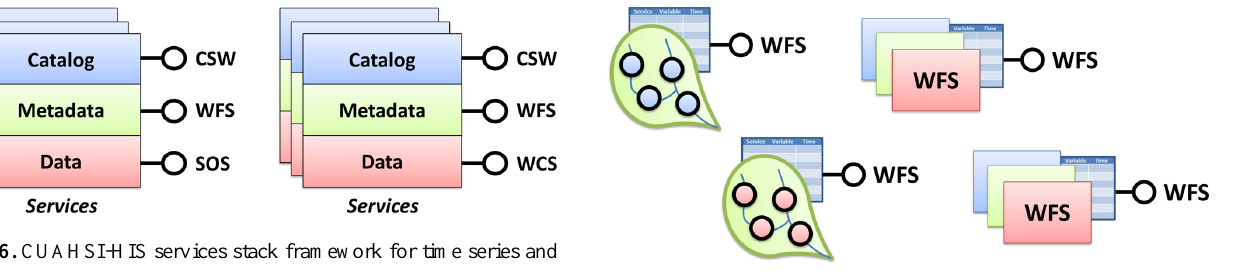
Fig. 7. CUAHSI-HIS metadata services for time series and cover-